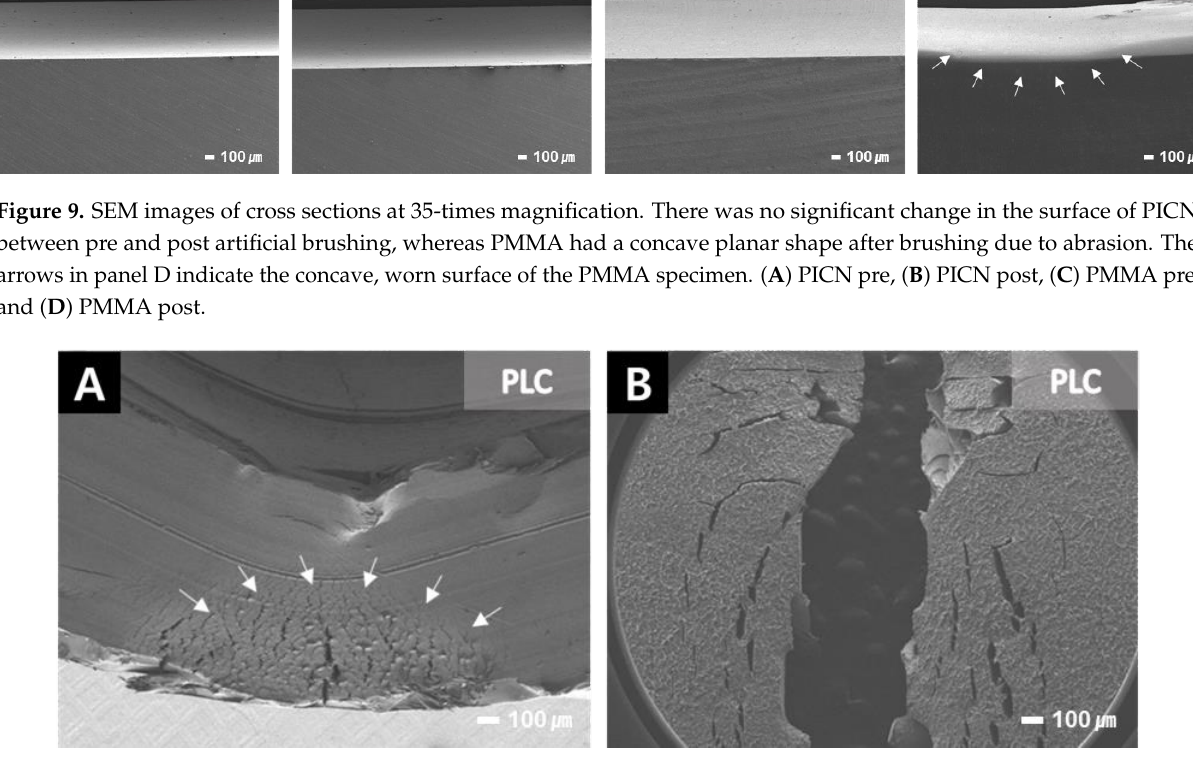
Figure 9. SEM images of cross sections at 35-times magnification. There was no significant change in the surface of PICN between pre and post artificial brushing, whereas PMMA had a concave planar shape after brushing due to abrasion. The arrows in panel D indicate the concave, worn surface of the PMMA specimen. ( A ) PICN pre, ( B ) PICN post, ( C ) PMMA pre, and ( D ) PMMA post.